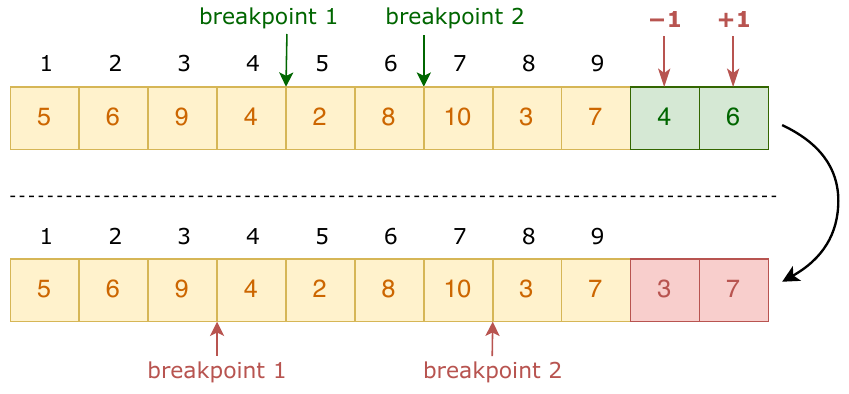
Figure 6. Example process of drift